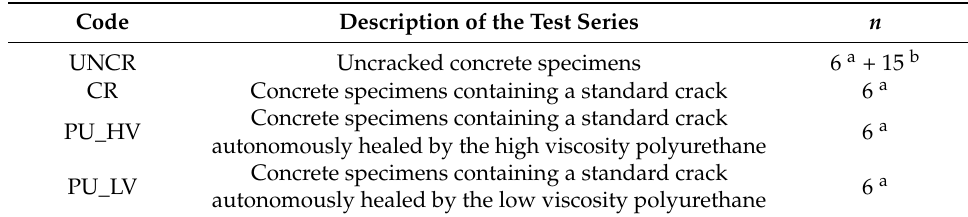
Table 2. Specimen test series ( n = number of specimens).